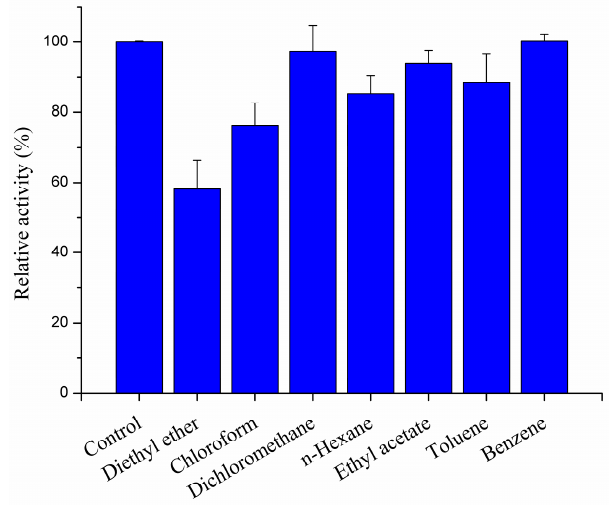
Figure 6. Effect of different organic solvents on pfGDPD activity. The enzyme solution was incubated separately with each organic solvent (final concentration 50%, v / v ) at 4 °C for 1 h, and then the residual activity of enzyme was measured at 55 °C and pH 8.5 using BpNPP as substrate.